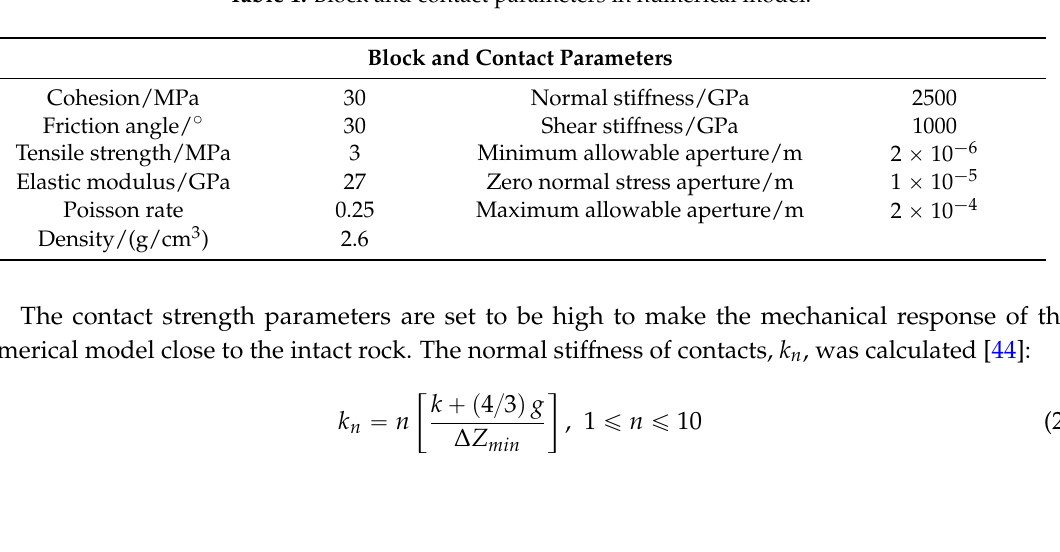
Table 1. Block and contact parameters in numerical